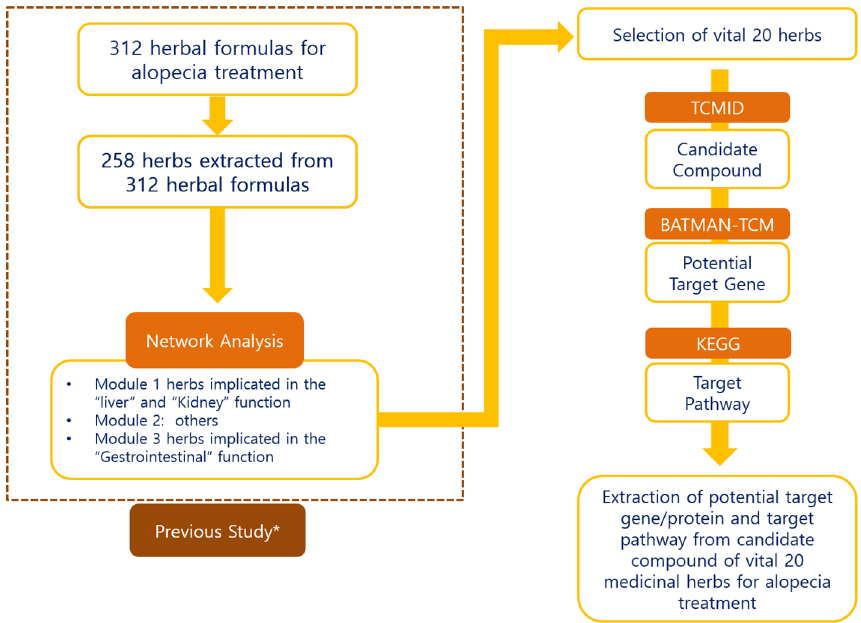
Figure 1. Schematic study workflow diagram . TCM traditional Chinese medicine, TCMID traditional Chinese medicine integrated database, BATMAN bioinformatics analysis tool for molecular mechanism, KEGG Kyoto encyclopedia of genes and genomes. Asterisk: Previous study: Leem et al. 2018 16 .